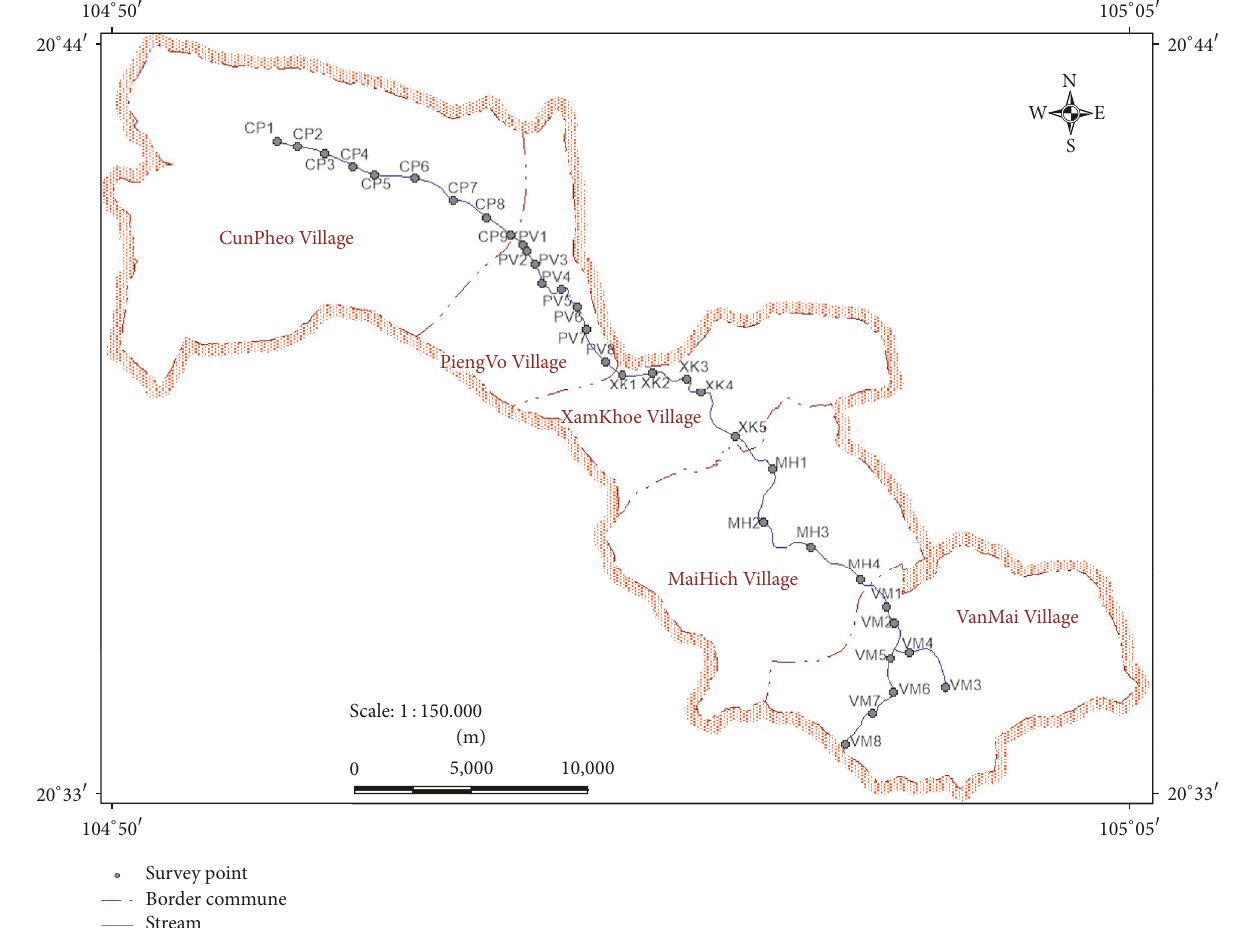
Figure 1: Map of the sampling sites in Mai Chau province, the Northern